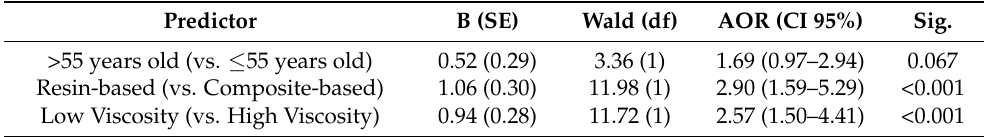
Table 4. Regression analysis of composite restoration failure, Palacky University Hospital, 2014–2018 ( n = 469). Predictor B (SE) Wald (df) AOR (CI 95%) Sig. >55 years old (vs. ≤ 55 years old) 0.52 (0.29) Resin-based (vs. Composite-based) 1.06 (0.30) <0.001 Low Viscosity (vs. High Viscosity) 0.94 (0.28)